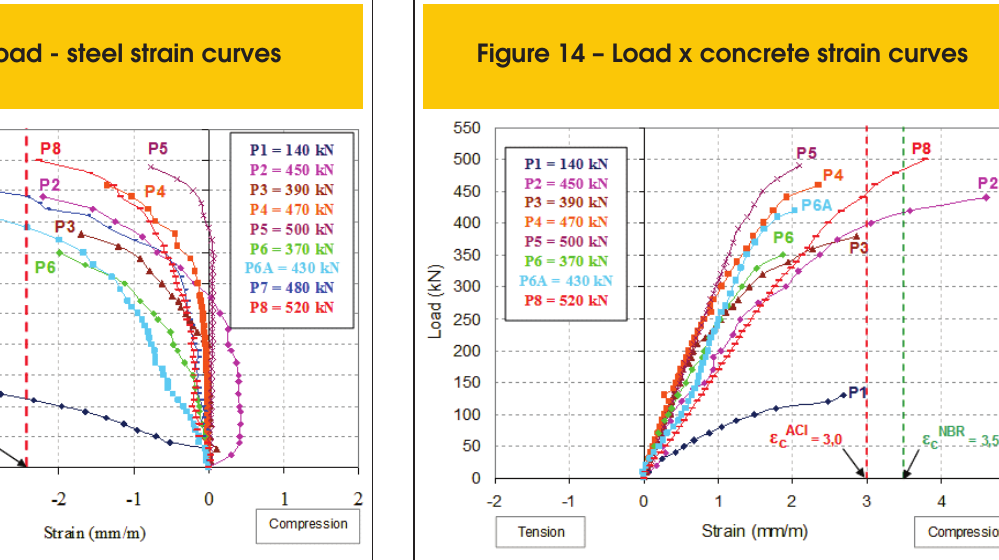
Figure 13 – Load - steel strain curves Figure 14 – Load x concrete strain